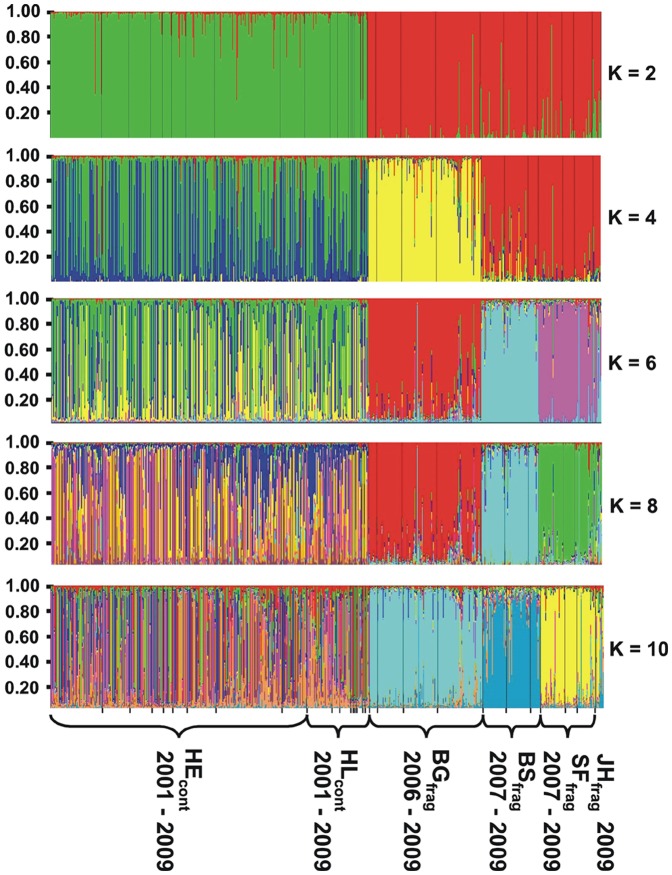
Assignment of dormouse individuals of six sites at two locations (Tübingen: HEcont and HLcont; Ulm: BSfrag; JHfrag; SFfrag; BGfrag) in south western Germany to different source populations assuming different numbers of potential source populations (K = 2, 4, 6, 8, 10).Different colours indicate the possibility of different source populations. Colours in each column show the likelihood (%) to which source population an individual can be assigned.